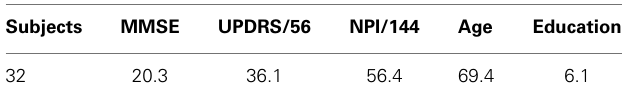
Table 1 | Socio-demographical data of the whole study group; age and education are expressed in years